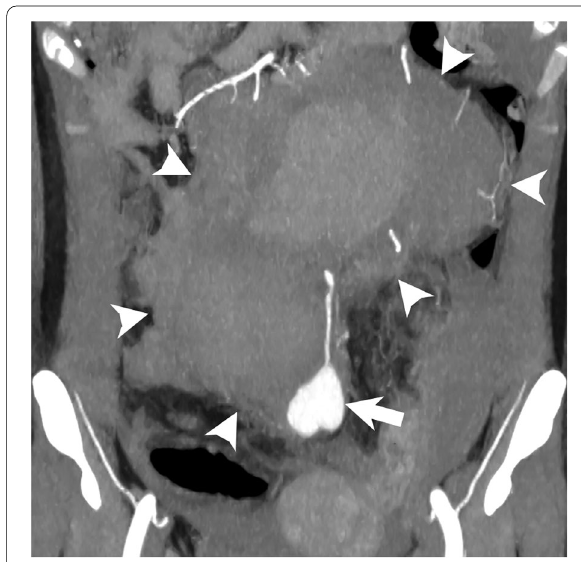
Fig. 1 Coronal partial maximum intensity projection image reconstructed from computed tomography angiography showing a ruptured superior rectal artery trunk aneurysm (arrow) and a large retroperitoneal hematoma (arrowheads)